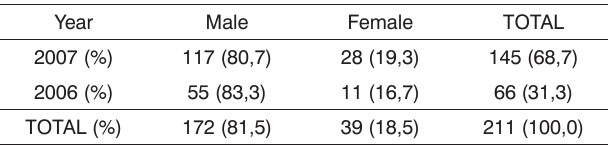
Table 2. Distribution and frequency of the population per year and gender of patients.